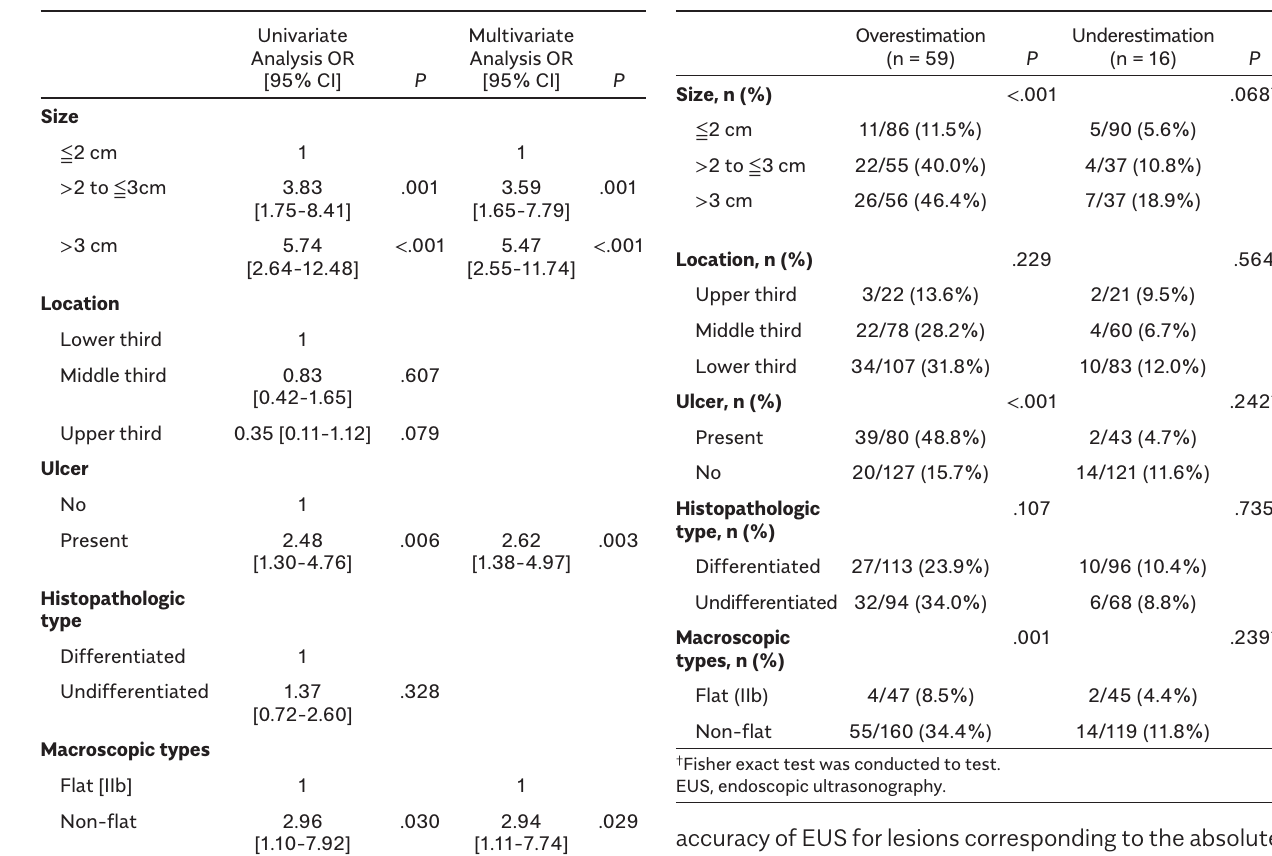
accuracy of EUS for lesions corresponding to the absolute criteria (97.3%; 36/37) was significantly higher than that for those corresponding to the expanded criteria (71.9%; 46/64, P = .002) (Figure 3). Table 5. Multivariate Analysis for Factors Affecting the Overestimation of EUS for the Depth of Invasion Multivariate analysis OR [95% CI]